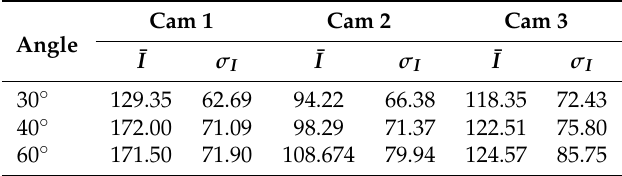
Table A5. Evaluation of the orientation of the